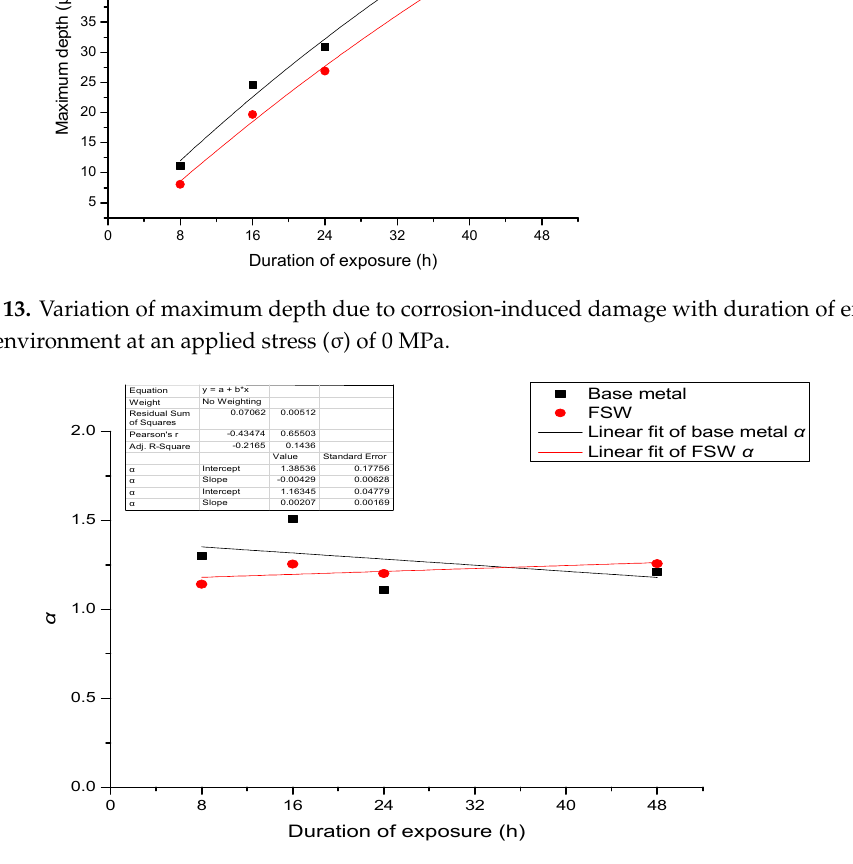
Figure 14. Variation of α with duration of exposure at applied stress ( σ ) of 0 MPa.